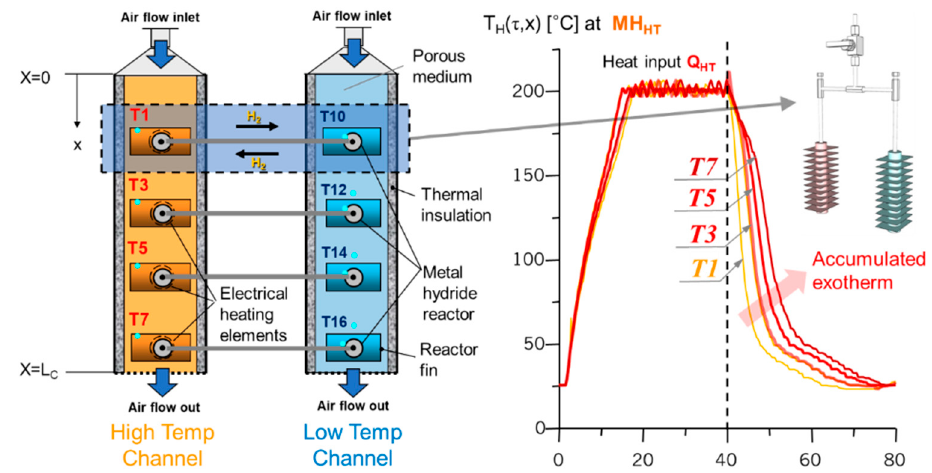
Figure 4. Metal hydride thermal energy conversion system with an arrayed dual metal hydride heat pump (MHHP) reactor pair units ( left ); the laboratory setup configuration is for the verification test of the system inducing superadiabatic TECW ( right ). Experimental results of the superadiabatic TECW is induced by deploying arrayed dual metal hydride reactor pairs in an adiabatic porous media. The temperature profiles, T1–T7, show the temperature variation over time in each location of the high-temperature channel ( left ), demonstrating the e ff ectiveness of the configuration on the formation of TECW accumulating-induced heat.